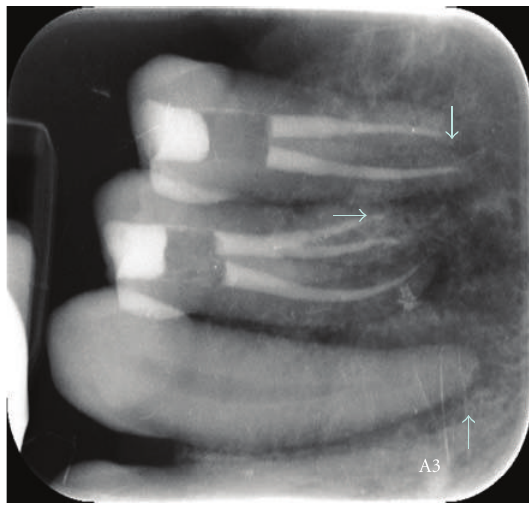
Figure 8: Case 5. Periapical